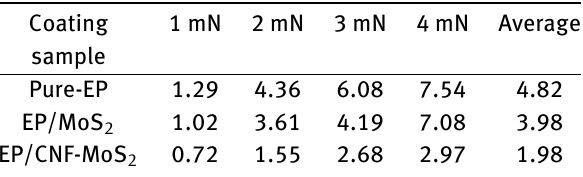
Table 2: Average creep compliance of coating specimens